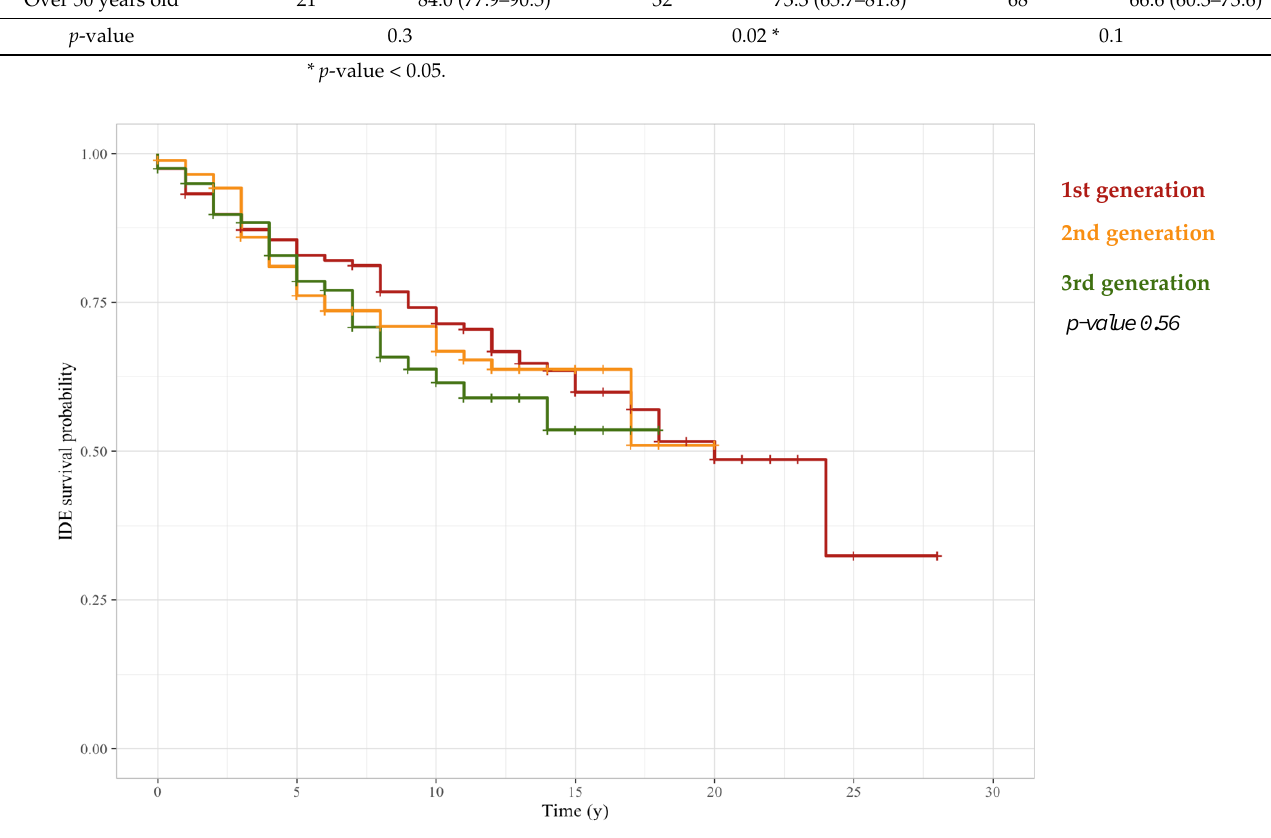
Figure 5. IDEFS curves related to a Kaplan – Meier analysis performed on patients under 50 years old stratified with respect to three different adjuvant chemotherapy generations: 1st generation CMF, 2nd generation Anthracycline, 3rd generation Taxanes/Taxanes and Anthracycline. The log-rank test demonstrated that there was not a statistically significant difference among the three populations.